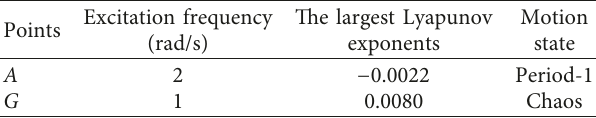
Table 2: System responses for different typical points ( F � 1.5 N). Excitation frequency Points (rad/s)